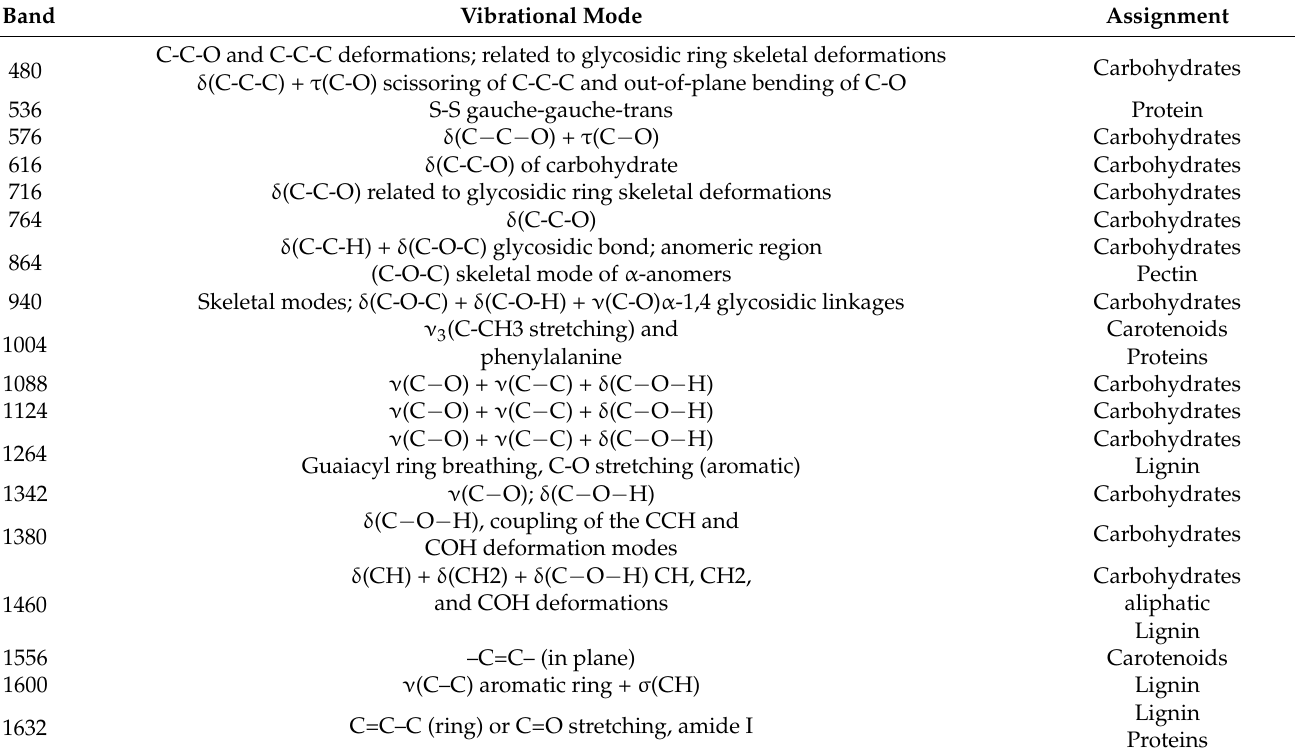
Table 1. Vibrational bands and their assignments in Raman spectra of wheat